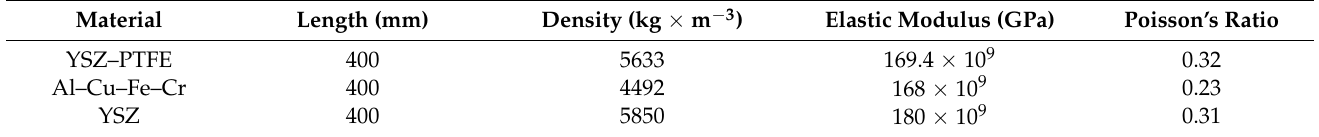
Table 5. Hard-coating parameters.